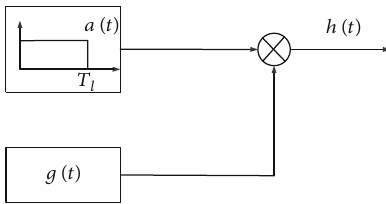
Figure 2: Signal model of fi nite duration for random